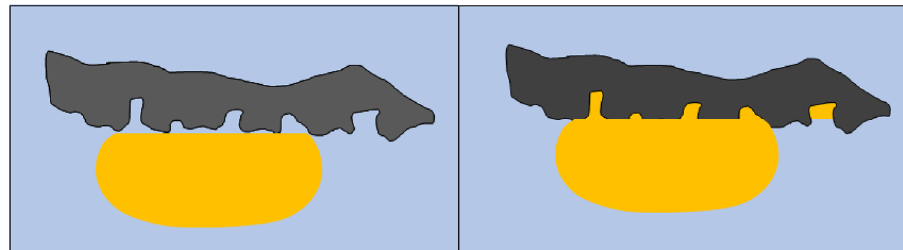
Fig. 10 Oil drop on an unaged rock surface immersed in water (left) and oil drop on an aged rock immersed in water (right)